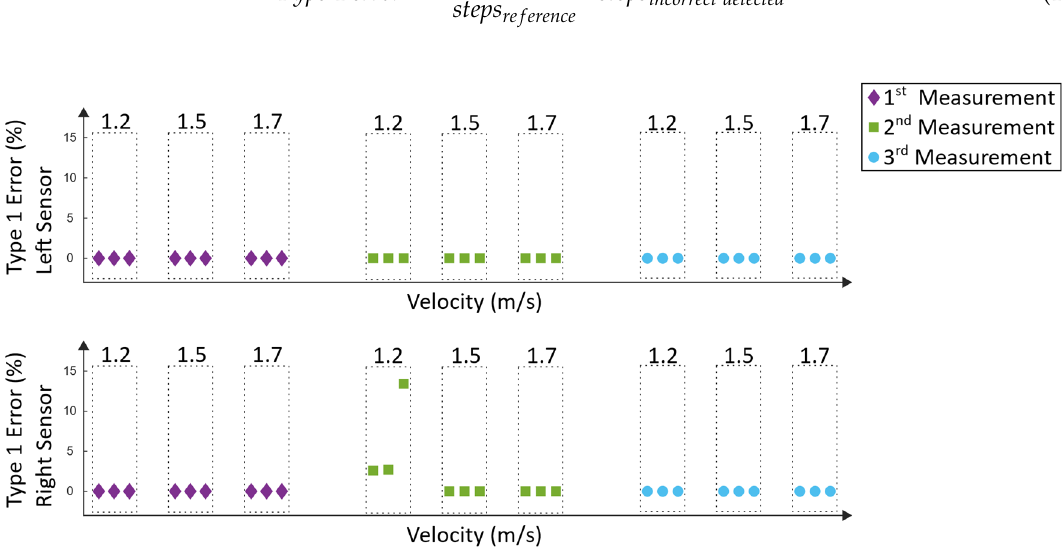
Figure 24. Detection rate of the Lyra measurements . Similar to the analysis of the Lokomat measurements, the type-1 errors of the Lyra system (Figure 25 ) represent the incorrected detected steps, which could trigger hazardous electrical stimulation.